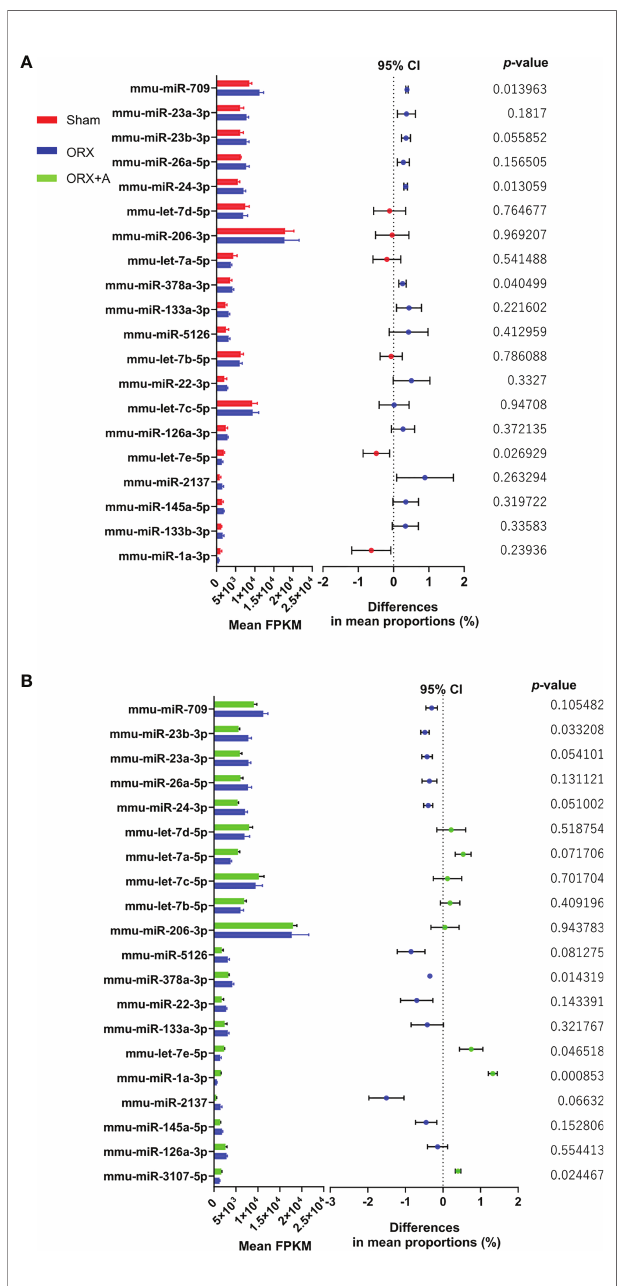
FIGURE 1 | Top 20 miRNAs in the soleus muscle ranked using the weighted average difference method. In fl uence of miRNAs in Sham, ORX, and ORX+A mice was assessed using the weighted average differences method, and the assessed in fl uence of the genera are ranked from top to bottom. Top 20 miRNAs are shown. Differences between these miRNAs were evaluated using paired t ‐ tests (n = 3). Left, histogram showing the mean fragments per kilobase of exon per million reads mapped (FPKM) of miRNAs (mean + standard deviation); right, 95% con fi dence interval (CI) of the differences in mean proportion and P ‐ value by paired t ‐ test are shown. (A) Sham vs. ORX mice. (B) ORX vs. ORX+A mice. Sham: red, ORX: blue, ORX+A: